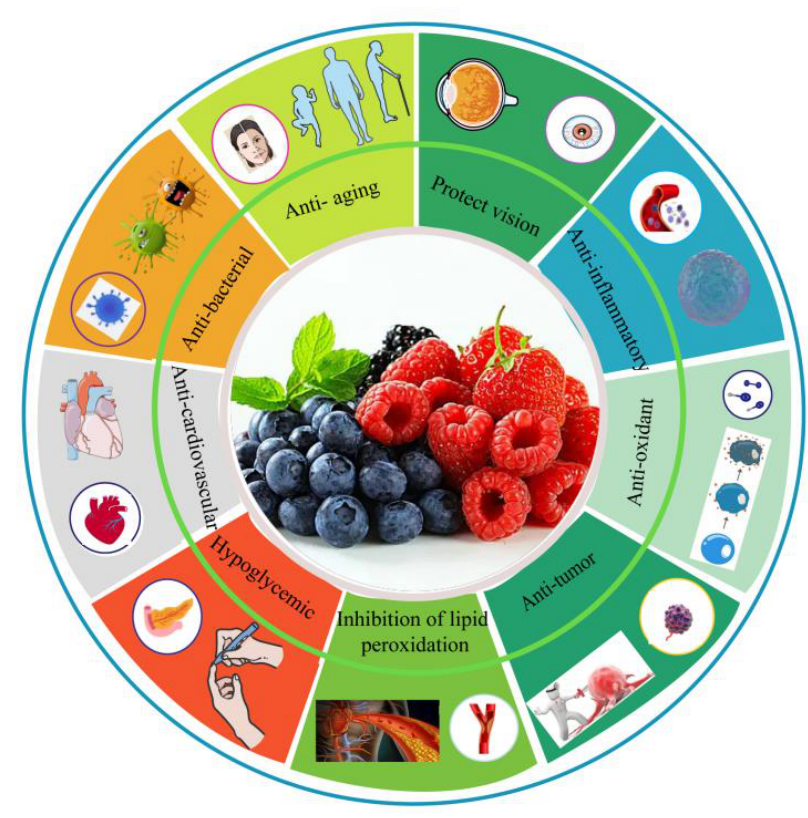
Figure 4. The biological activities of berry anthocyanins.